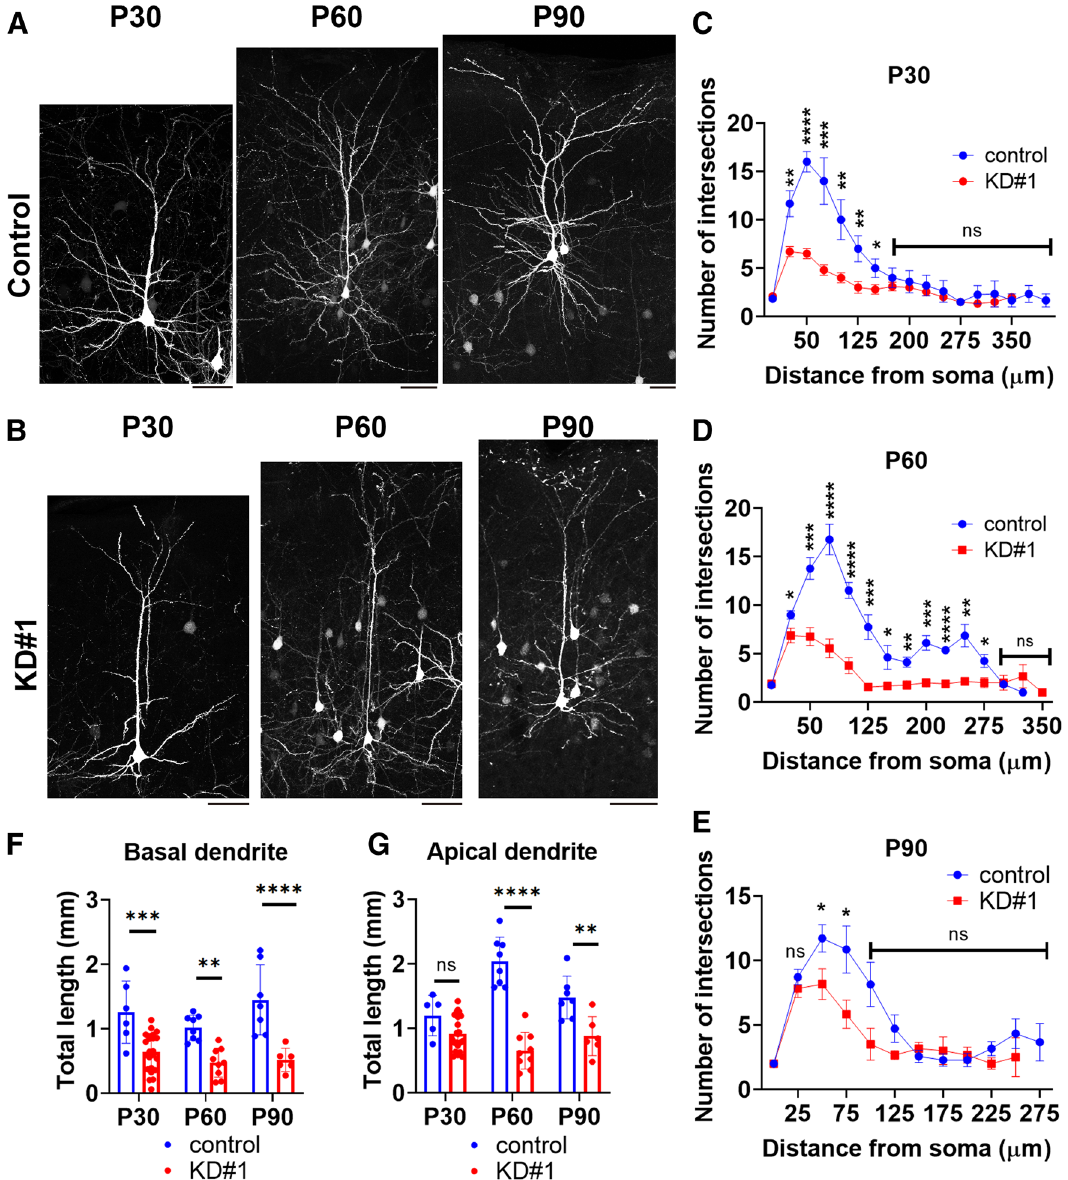
Figure 8. Long-term effects of Wdr45-knockdown on dendrite growth in vivo. ( A,B ) For sparse expression, pCAG-loxP-GFP was co-electroporated with pCAG-M-Cre together with pSuper-H1.shLuc (control) ( A ) or pSuper-Wdr45#1 (KD#1) ( B ) at E14.5. After fixation at P30, P60 or P90, coronal sections were prepared and stained for GFP. Representative average z-stack projection images of layer II/III cortical neurons were shown. Scale bars, 50 μm. ( C – E ) Branch points of dendrites were analyzed by Sholl test. One section from each brain was analyzed for P30 (control, n = 10; KD#1, n = 11) ( C ), P60 (control, n = 6; KD#1, n = 8) ( D ) and P90 (control, n = 3; KD#1, n = 3). Error bars indicate SD of the results from 10 to 15 neurons; * p < 0.05, ** p < 0.01, *** p < 0.001 and **** p < 0.0001 by t-test (vs. control). ( F,G ) Total dendritic length was calculated for basal ( F ) as well as apical dendrites ( G ). Error bars indicate SD of the results from 10 to 15 neurons; * p < 0.05, ** p < 0.01, *** p < 0.001 and **** p < 0.0001 by t-test (vs.